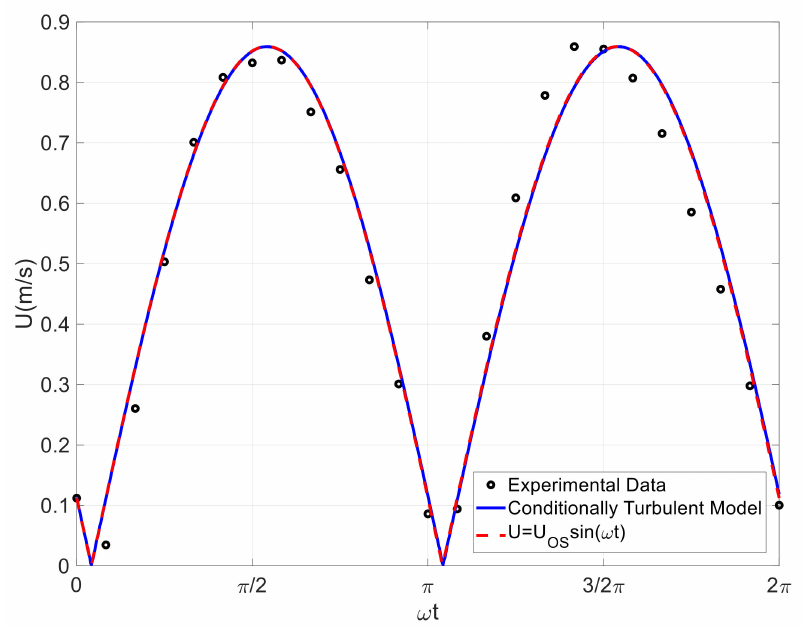
Figure 4. Comparison between the computationally enforced harmonic bulk flow and the phase- averaged experimental data for Case 1: Re os = 5830, α =